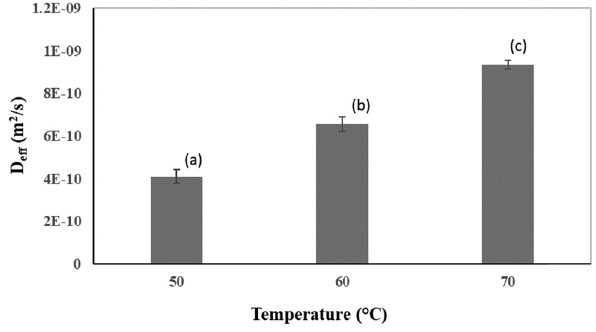
Figure 4: Variation in D eff for the drying of pomegranate arils at di ff erent CV temperatures. The bars represent mean values and the corresponding standard deviations. Bars with the same letter are not signi fi cantly di ff erent according to ANOVA and Tukey test ( p < 0.05 ) .